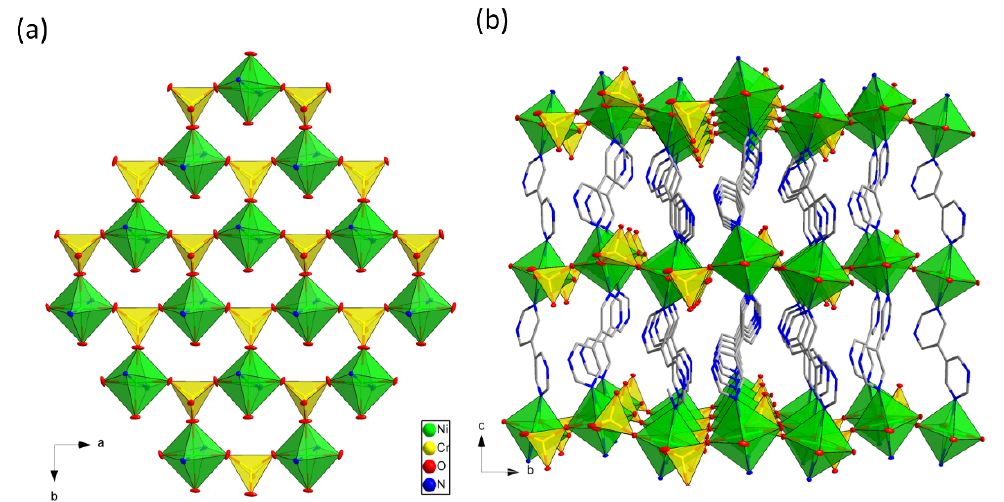
Figure 1. The coordination environments of compound 1 . The H atoms have been omitted for clar- ity. (Symmetry code: ( A ) 1 − x, − 0.5 + y, 2 − z; ( B ) 1 + x, y, z; ( C ) x, y, 1 + z; ( D ) 1 − x, − 0.5 + y, 2 − z; ( E ) 1 + x, y, z; ( F ) x, y, − 1 + z). A – E refer symmetrical cords of atom in Figure 1, which are labled as O2A, O3B, Ni1D, Ni1E, and Ni1F. Figure 2. ( a ) Polyhedral view of the Ni(II)-CrO 4 inorganic layer along the c axis, and ( b ) the 3D pillar-layered structure of compound 1 along the b axis. The NiN 2 O 4 and CrO 4 sites are shown as green octahedrons and yellow tetrahedrons, respectively.